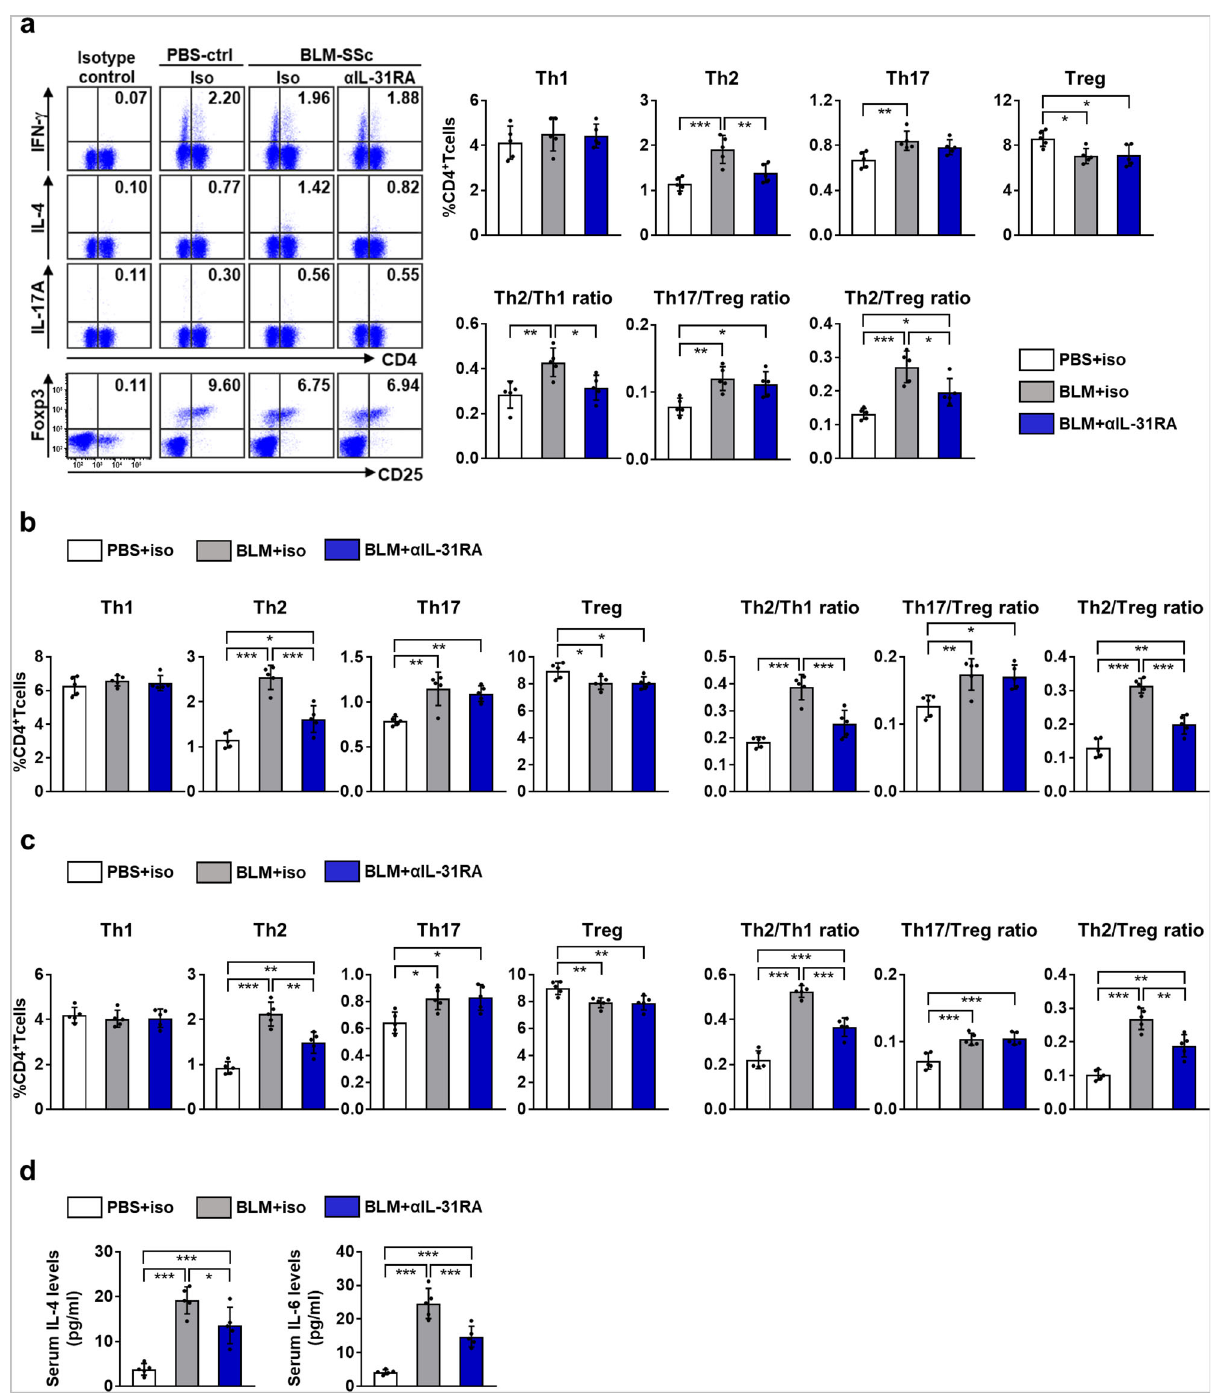
immunoprecipitation with normal rabbit IgG (Santa Cruz Biotechnology) as the negative control. The immunoprecipitated chromatin was analyzed by agarose gel electrophoresis and quantitative real-time PCR using primers speci fi c for the HS4 region: 43 5 ′ - TTCACATGAGCATTTGAGTGTATTG -3 ′ and 5 ′ - TCGTCAGTGTGTAACCCTCATC -3 ′ . exact probability test for frequency analysis, and Spearman ’ s rank correlation coef fi cient for clinical correlation. One-way analysis of variance followed by Tukey ’ s post hoc comparison test was used for multiple group comparison. P values less than 0.05 were considered signi fi cant. All analyses were performed using GraphPad Prism 7.03 (GraphPad Software, La Jolla, CA,